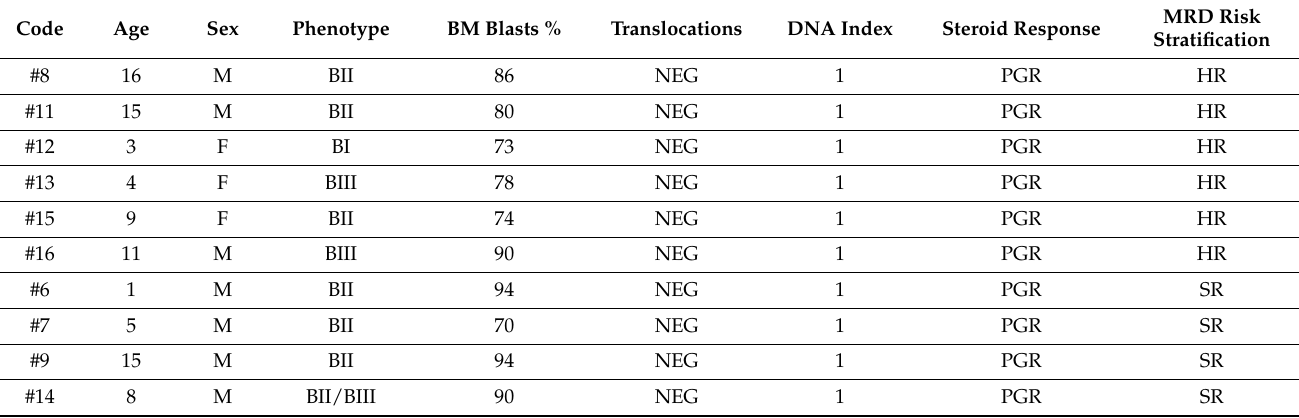
Table 1. Patients‘